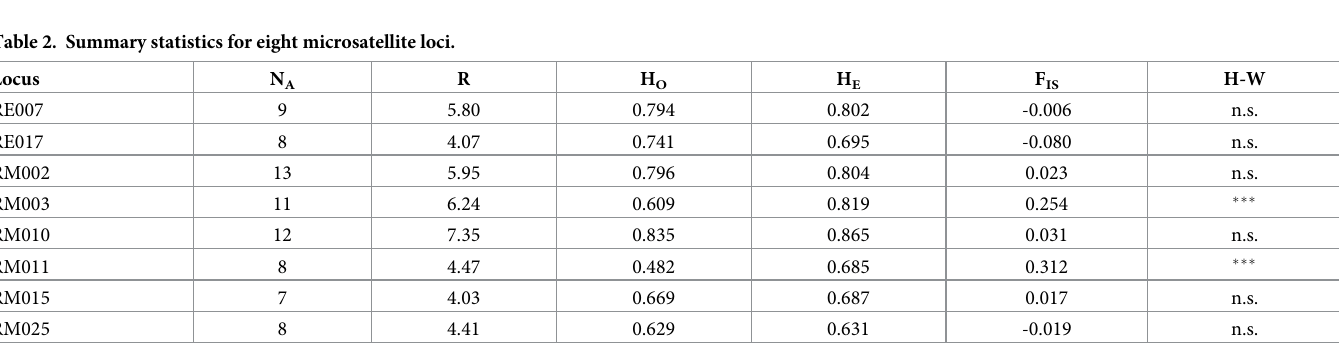
Table 2. Summary statistics for eight microsatellite